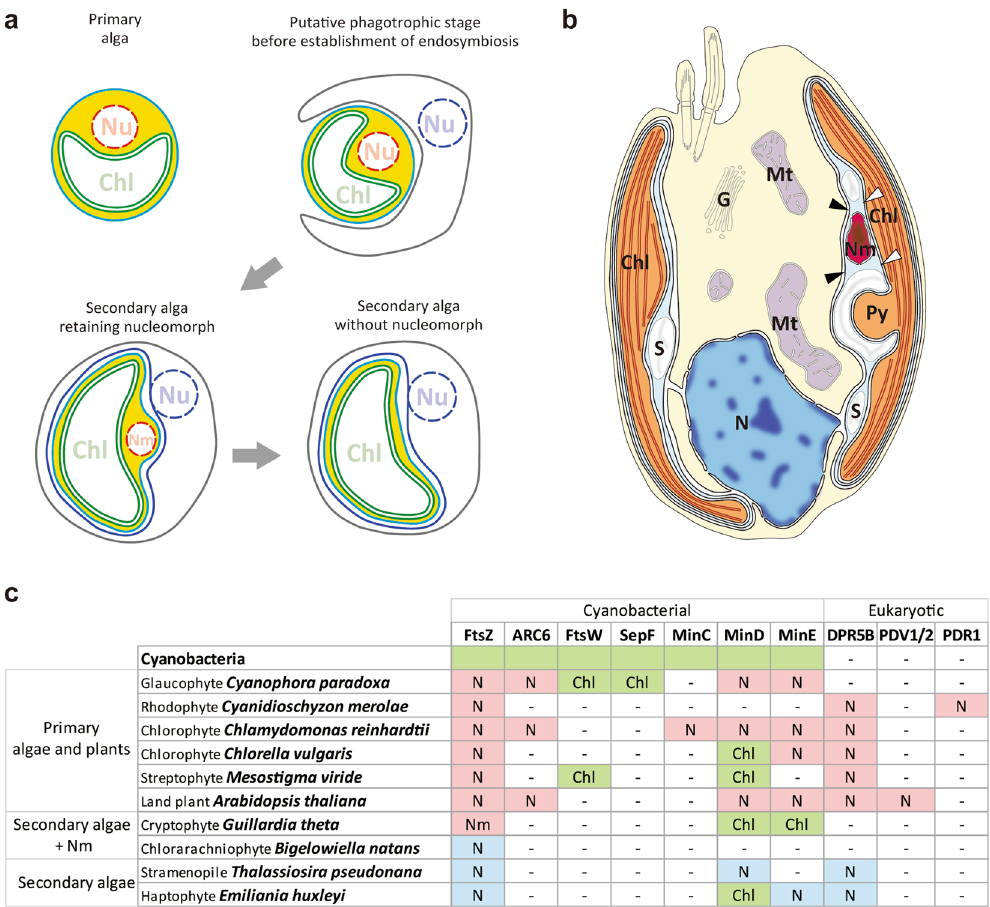
Figure 1. A diagram showing the course of the establishment of secondary chloroplasts, illustration of the cryptophyte Guillardia theta and distribution of chloroplast division proteins in eukaryotes. ( a ) Schematic view of organelle reduction and membrane heredity through secondary endosymbiosis. The green double membrane, sky-blue membrane and blue membrane represent the inner and the outer chloroplast envelope membranes, periplastidal membrane and chloroplast ER, respectively. The space indicated in yellow is the periplastidal compartment (PPC), which is homogeneous with the cytoplasm in primary endosymbiotic algae. The evolutionary stage of cryptophytes and chlorarachniophytes corresponds to secondary alga that possesses a nucleomorph. ( b ) Schematic drawing of the ultrastructure of G . theta based on McKerracher & Gibbs (1982). Chl, chloroplast; N, nucleus; Nm, nucleomorph; Py, pyrenoid; S, starch; Mt, mitochondria; G, Golgi body. The nucleomorph is located in the PPC between the outer chloroplast envelope (white arrowheads) and the periplastidal membrane (black arrowheads). ( c ) Distribution of chloroplast division proteins that are descended from the cyanobacterial ancestor of chloroplasts and the eukaryotic host (based on Miyagishima et al . 10 and Hirakawa & Ishida 2015). The “Chl”, “N” and “Nm” in each column indicate that the gene is encoded in the chloroplast, nucleus and nucleomorph genome, respectively. The hyphen indicates that the gene is not found in the corresponding organism. Proteins encoded in the cyanobacterial or chloroplast genome are boxed in green, proteins encoded in the nuclear genome of primary algae or plants are boxed in pink and proteins encoded in the nuclear genome of secondary algae are boxed in blue. The accession numbers of the amino acid sequences are listed in Supplementary Table